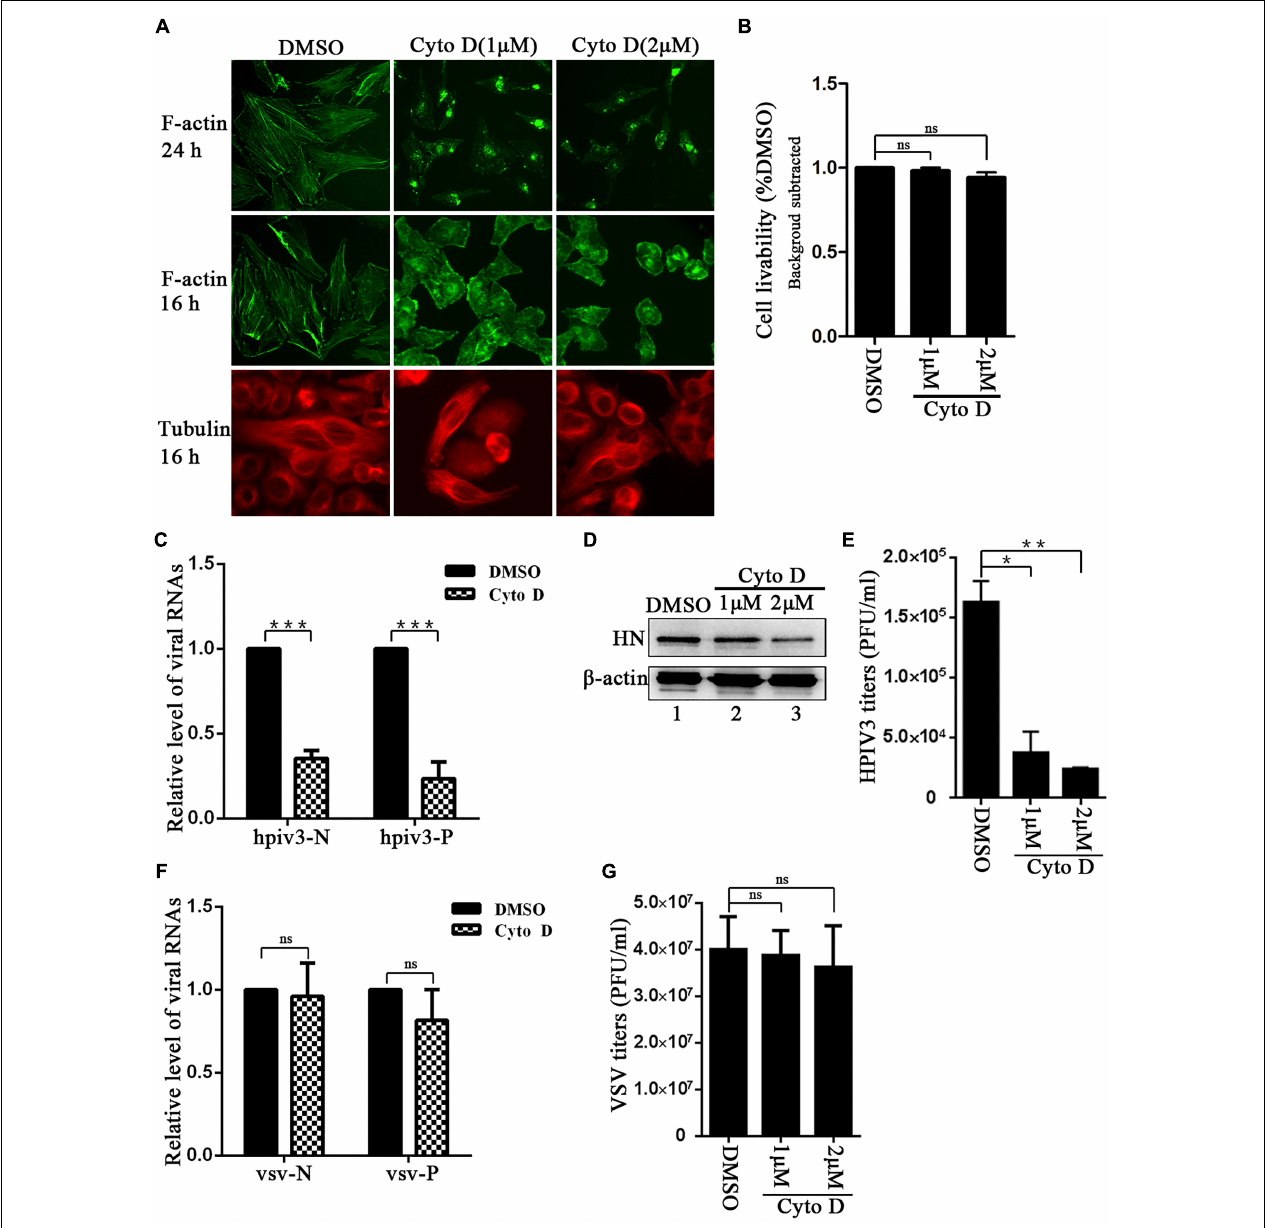
FIGURE 1 | F-actin disruption specifically affects HPIV3 RNA synthesis. (A) Hela cells were treated with cyto D (1 µ M or 2 µ M) or control DMSO. F-actin structures were stained with phalloidin-AF488 at 24 h and 16 h after incubation, microtubules were stained with mouse anti- α -tubulin primary antibody and goat anti-mouse AF568 at 16 h after incubation as described in “Materials and Methods” section. Images were observed using an immunofluorescence (IF) microscope. (B) Hela cells incubated with cyto D or DMSO for 24 h, and the cell livability was examined by CCK8 assay as the manufacture’s instruction. There was no significant toxicity when Hela cells were treated with 1 µ M or 2 µ M cyto D. Student’s test: ns, non-significant. (C) Hela cells were infected with HPIV3(MOI = 1) for 8 h, then cyto D (2 µ M) or DMSO were added, at 24 h postinfection, the cells were collected and real-time PCR was performed as described in “Materials and Methods” section to detect HPIV3 N and P RNAs. Cellular β -actin mRNA was used as control. Samples were examined in triplicate, and data are means ± SD from three experiments. Student’s test: ∗∗∗ p < 0.001. (D,E) Hela cells were treated as above. At 24 h postinfection, cells were collected and viral protein was analyzed by Western blot (WB). Cellular β -actin was used as a loading control. Viral titers in the cell supernatant were determined by plaque assay as described in “Materials and Methods” section. Data are means ± SD from three experiments. Student’s test: ∗ p < 0.05; ∗∗ p < 0.01. (F,G) Hela cells were infected with VSV at an MOI of 0.5 for 8 h, and then cyto D or DMSO were added. At 24 h postinfection, the cells were collected and real-time PCR was performed as described in “Materials and Methods” section to detect VSV N and P RNAs. Cellular β -actin mRNA was used as control. Samples were examined in triplicate, and data are means ± SD from three experiments. Student’s test: ns, non-significant. Viral titers in the cell supernatant were determined. Data are means ± SD from three experiments. Student’s test: ns, non-significant.